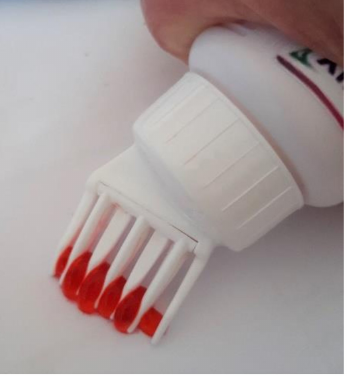
Figure 4. Comb-like dispenser fitted to the red dye gel